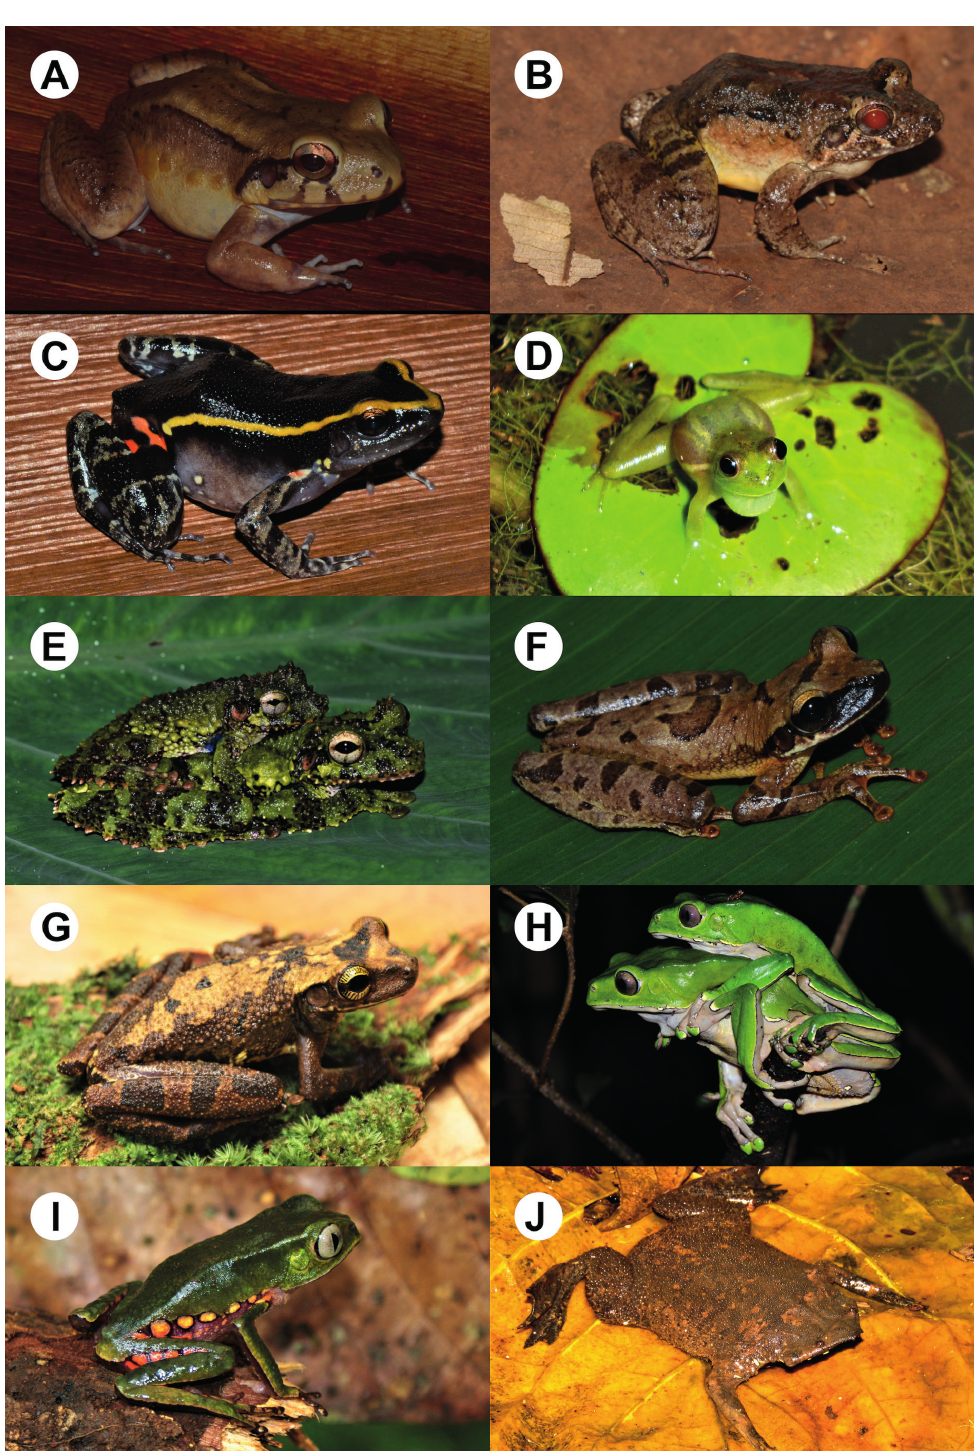
Fig. 6. Anuran species recorded in the state of Amapá. A . Leptodactylus stenoderma Jiménez de la Espada, 1875. B . Leptodactylus sp. C . Lithodytes lineatus (Schneider, 1799). D . Lysapsus bolivianus (Gallardo, 1961). E . Osteocephalus cabrerai (Cochran & Goin, 1970). F . Osteocephalus leprieurii (Duméril & Bibron, 1841). G . Osteocephalus taurinus (Steindachner, 1862). H . Phyllomedusa bicolor (Boddaert, 1772). I . Phyllomedusa vaillanti Boulenger, 1882. J . Pipa pipa (Linnaeus, 1758) . Photos: C.E. Costa-Campos (A, C–J) and T. R. Carvalho